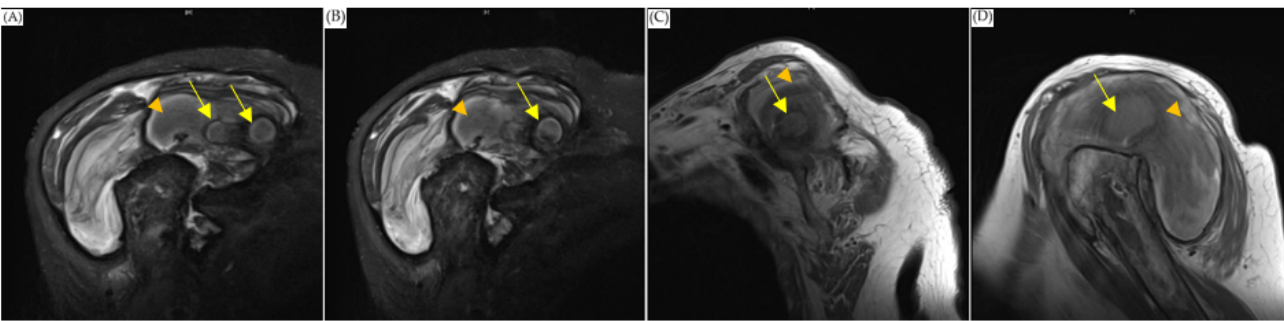
Figure 1. MRI of shoulder. ( A , B ) were coronary plane, ( C , D ) were sagittal plane. All the images showed: 1. An encapsulated cystic mass extending across subacromial and subdeltoid space (ar- rowhead), which was suggestive of abscess. 2. Enhancing nodule within the supraspinatus muscle, which was suggestive of inflammatory pseudotumor